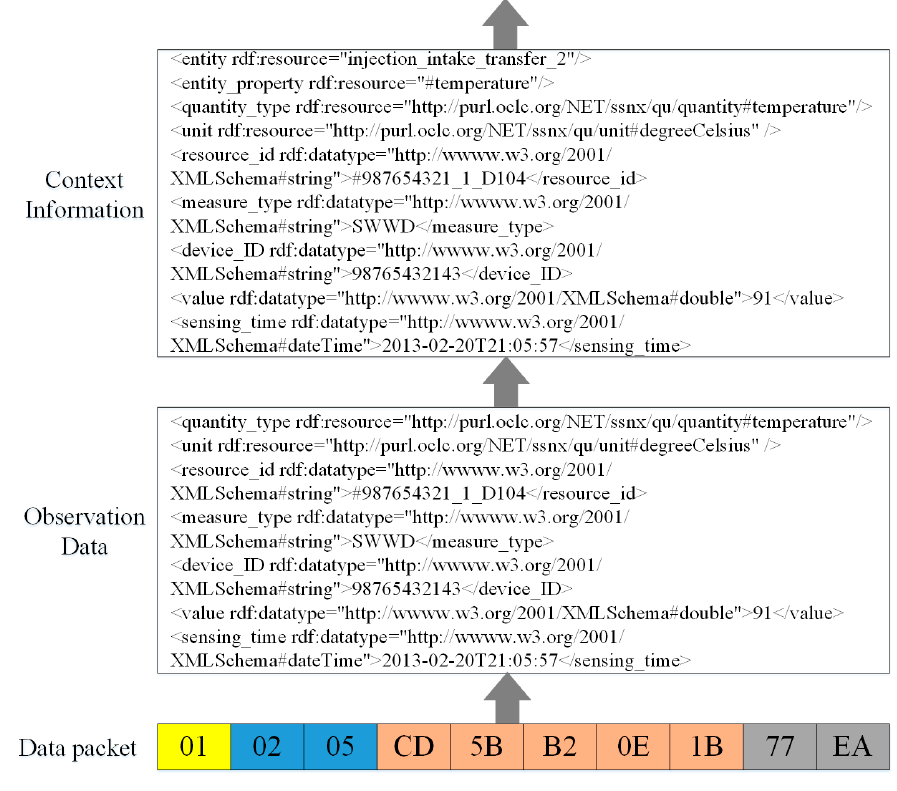
Figure 13. Summary temperature.